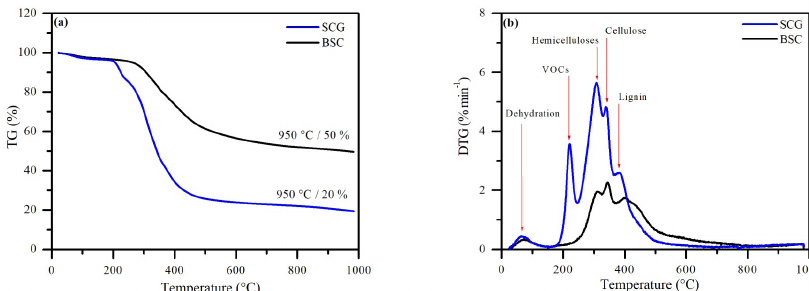
Figure 2. Thermal analysis of TG (a) and DTG (b) of BSC and SCG.